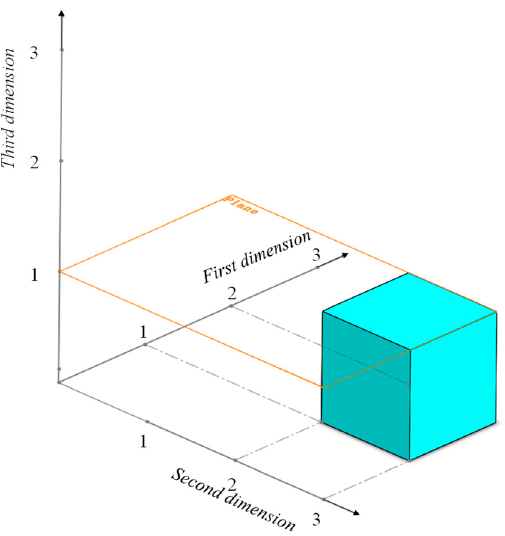
Figure 2. The relation of the ID of the blue subspace and the dimensions of the search space.